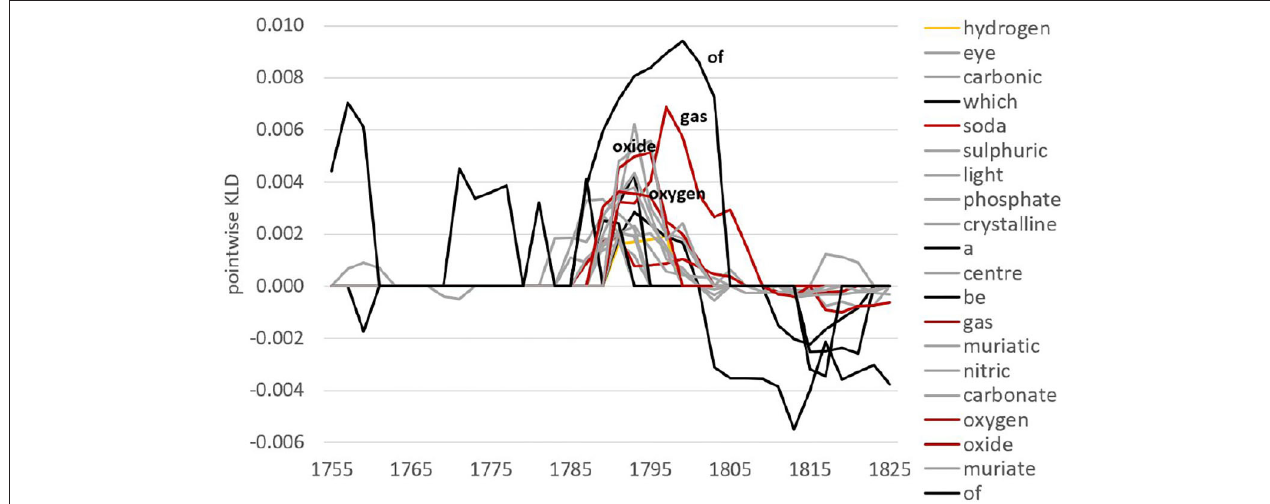
FIGURE 2 | Pointwise relative entropy based on lemmas for the FUTURE model in 1791.